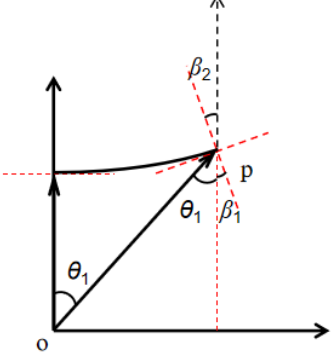
Figure 6. Central non-sheik surface optical design.